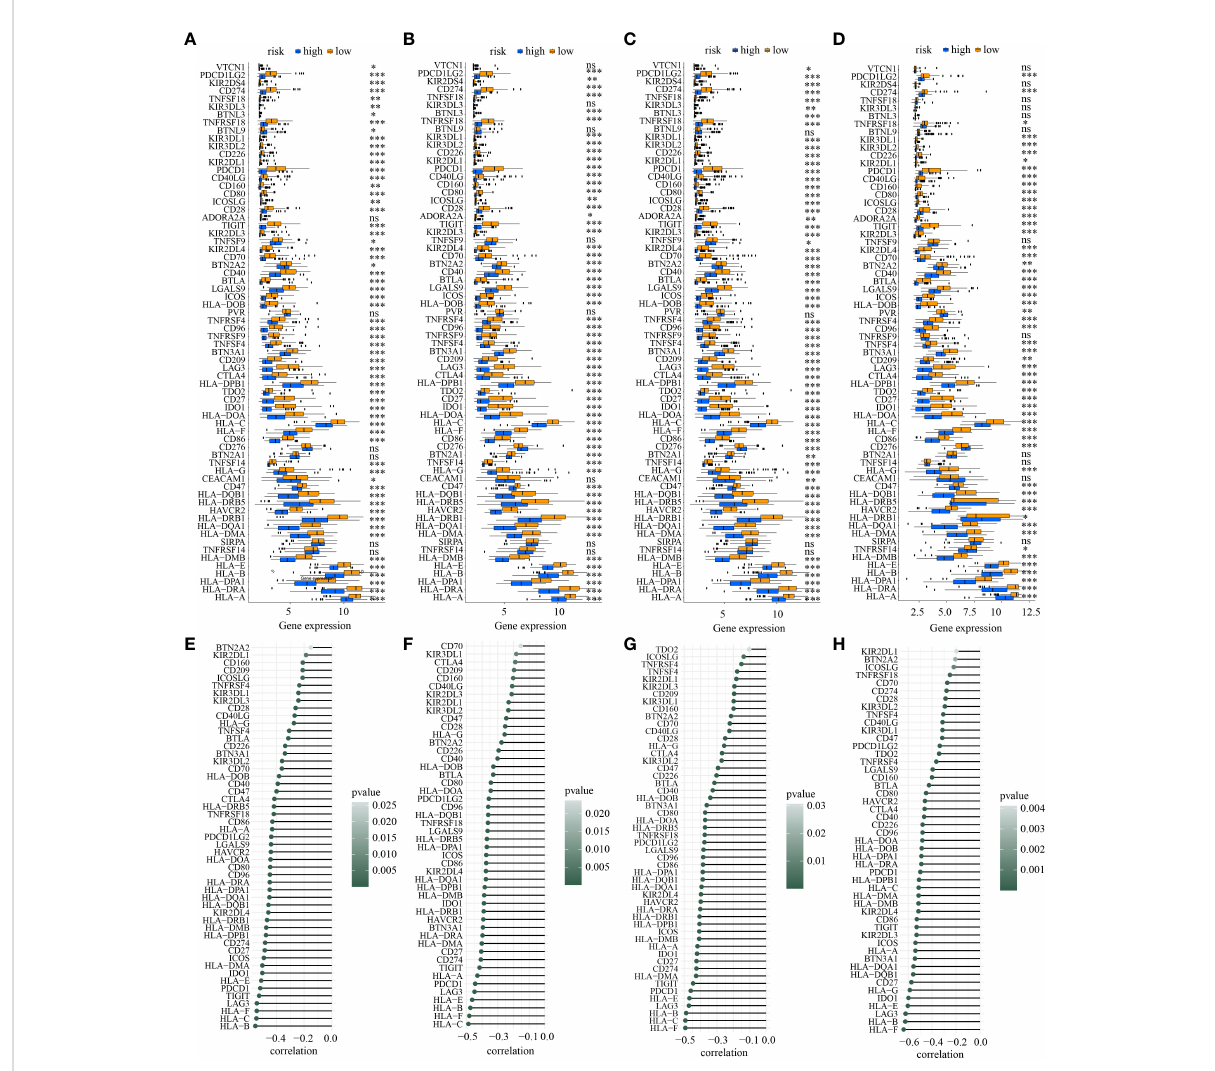
FIGURE 10 The discrepancy of the expression levels of ICGs in two risk subpopulations in train (A) , test1 (B) , test2 (C) , and test3 (D) and the correlation between ICDRS-based risk score and the expression of ICGs in train (E) , test1 (F) , test2 (G) , and test3 (H) . (* indicates p <0.05; ** indicates p < 0.01; *** indicates p < 0.001; ns: